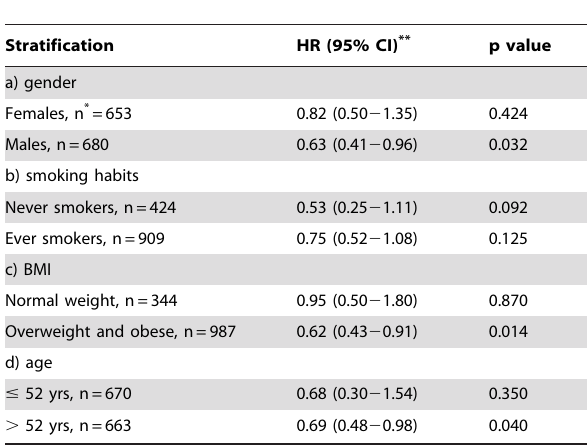
Table 3. HR for all-cause mortality for rs12778366 TC + CC genotypes in stratified analysis.